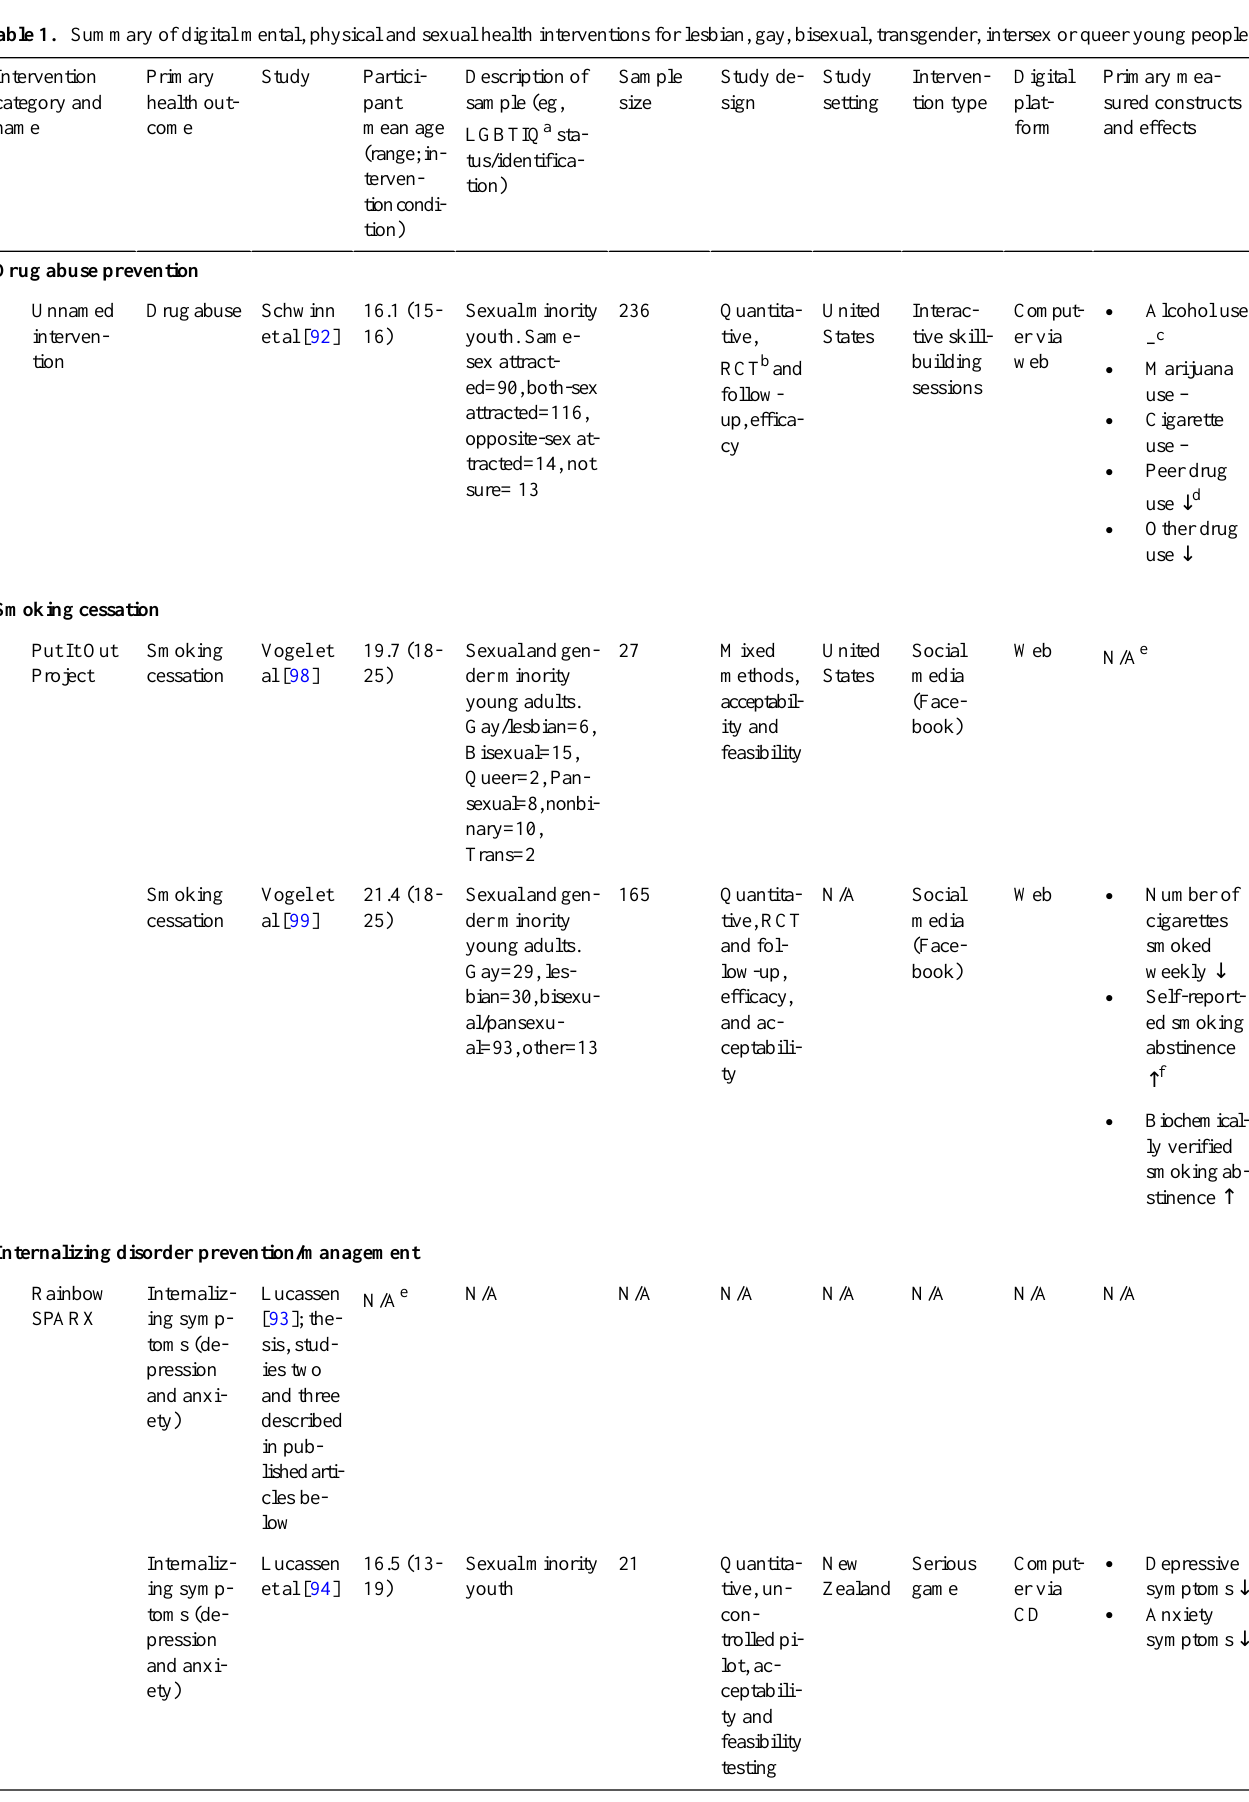
Table 1. Summary of digital mental, physical and sexual health interventions for lesbian, gay, bisexual, transgender, intersex or queer young people.